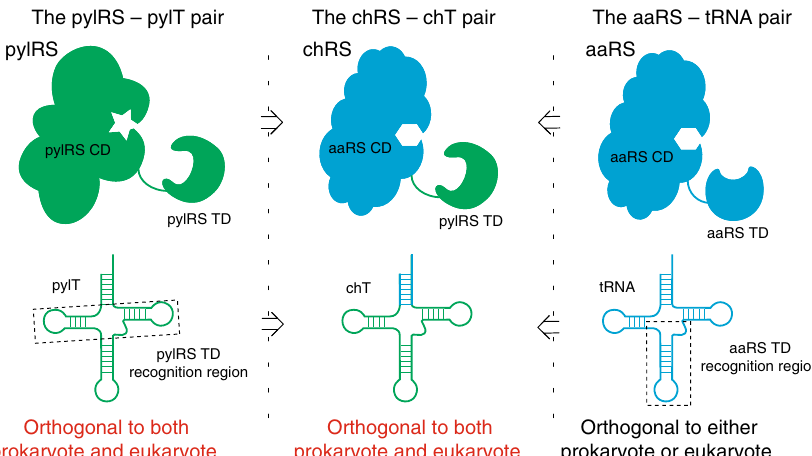
Fig. 1 The chimera design for orthogonalizing aaRS/tRNA pairs. a Cartoon structures of the pylRS/pylT pair (left panel); Cartoon structures of a common aaRS/tRNA pair (right panel); Cartoon structures of a chimeric aaRS (chRS) by fusing pylRS tRNA binding domain (TD) and aaRS catalytic domain (CD), a chimeric tRNA (chT) by replacing the pylT acceptor arm with an acceptor arm of a given tRNA (middle panel). The regions on the tRNAs that binds to the aaRS TD are highlighted by dashed boxes.